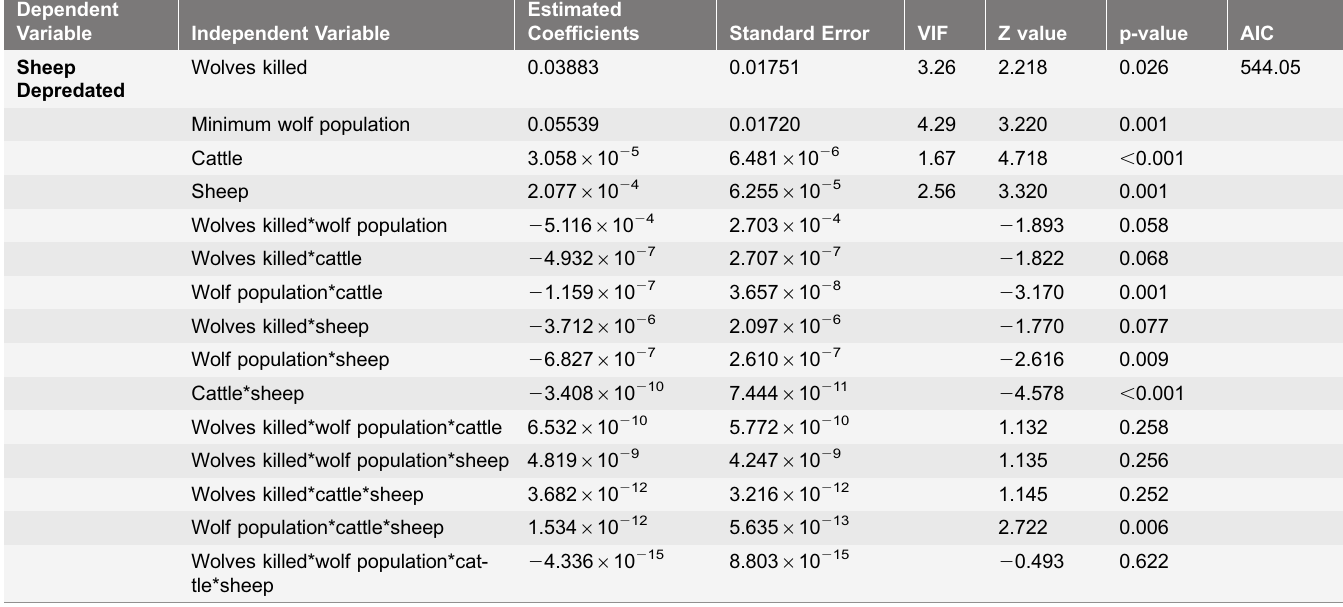
Table 4. Summary of best following year sheep depredated